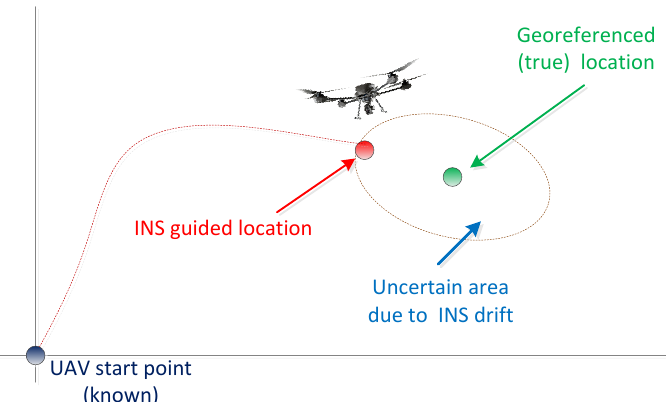
Figure 6. Illustration of the UAV inertial navigation strategy aided by the proposed aerial image registration system. The UAV starts from a known point and is guided by the intertial navigation system (INS) to the INS-computed georeference location (red dot). The green dot signifies the true georeferenced location. The UAV steered from the INS-computed georeferenced location to the true georeferenced location via the image registration system.